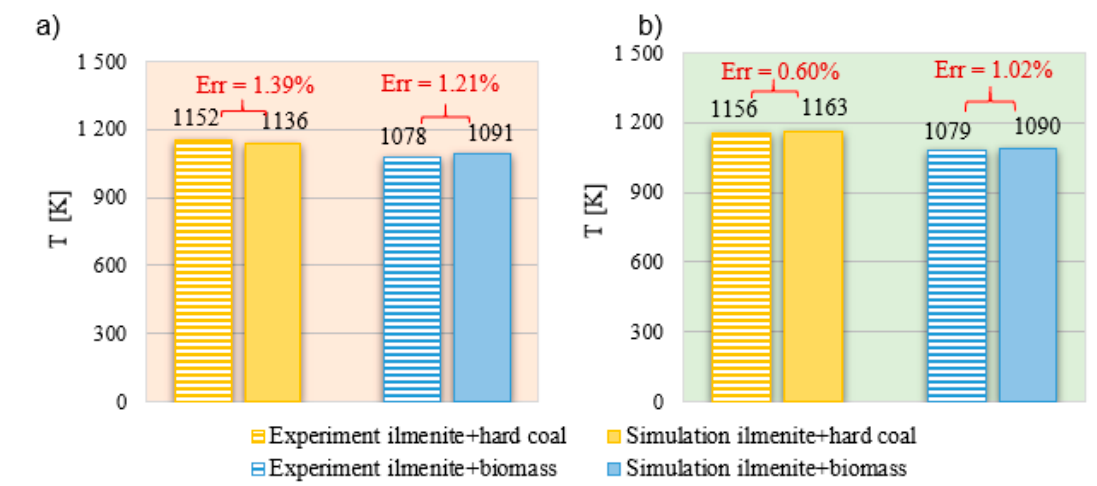
Figure 8. The average temperature in the reactors: ( a ) air reactor (AR) ( b ) fuel reactor (FR).